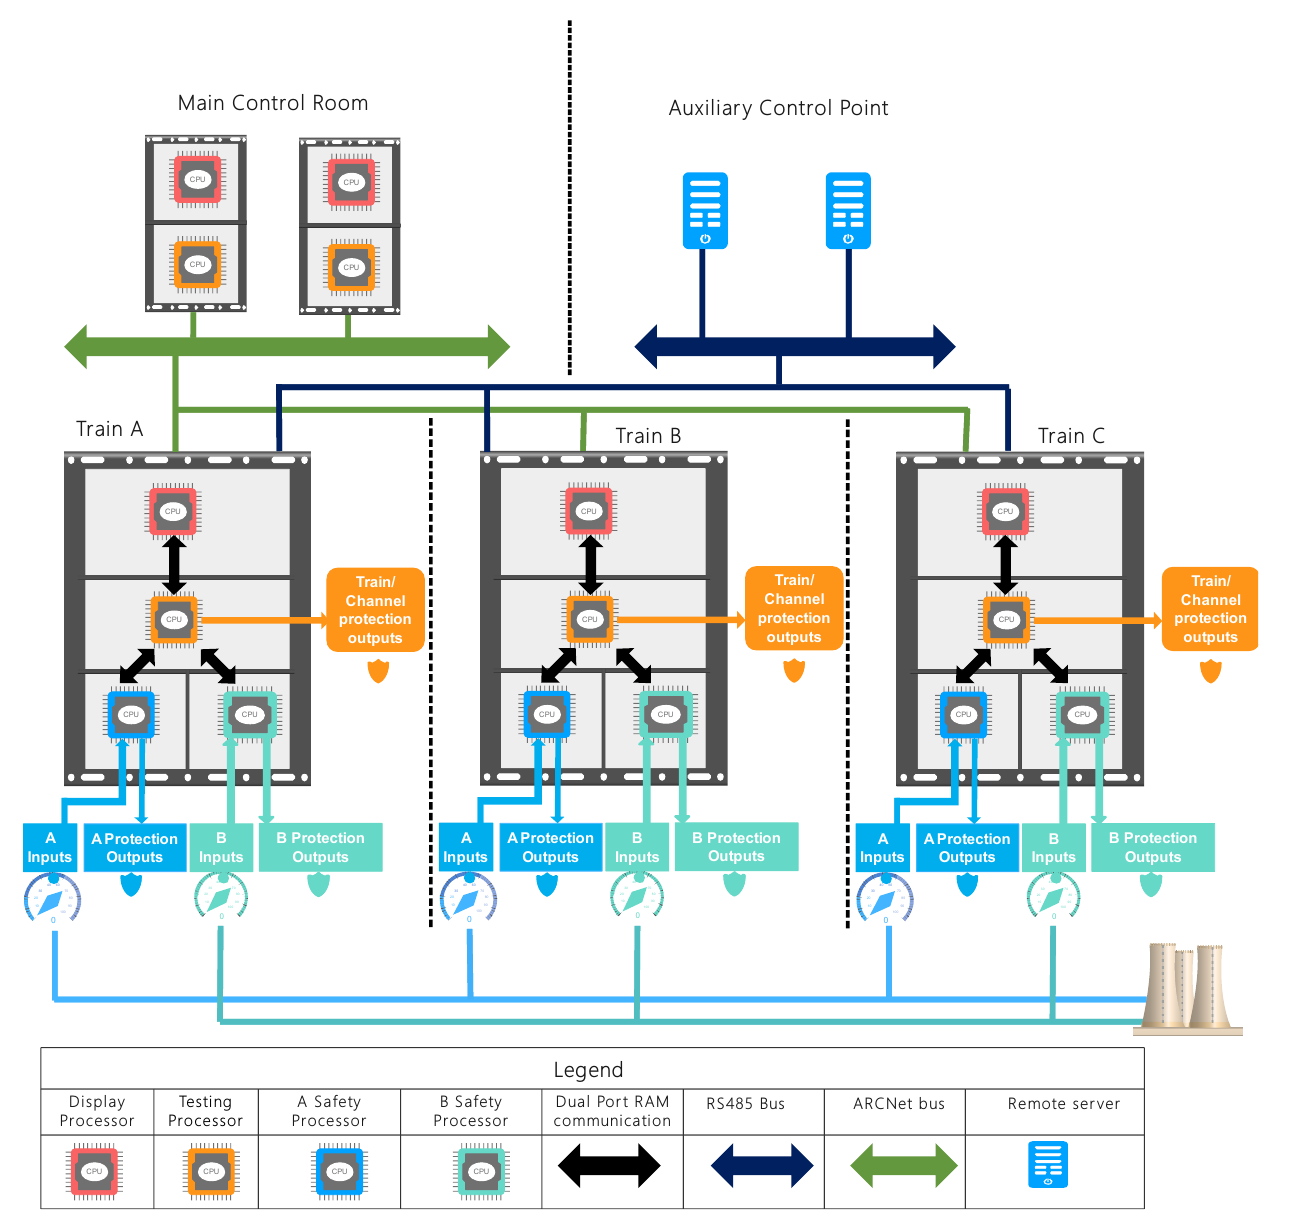
Figure 12. An overview of the used case